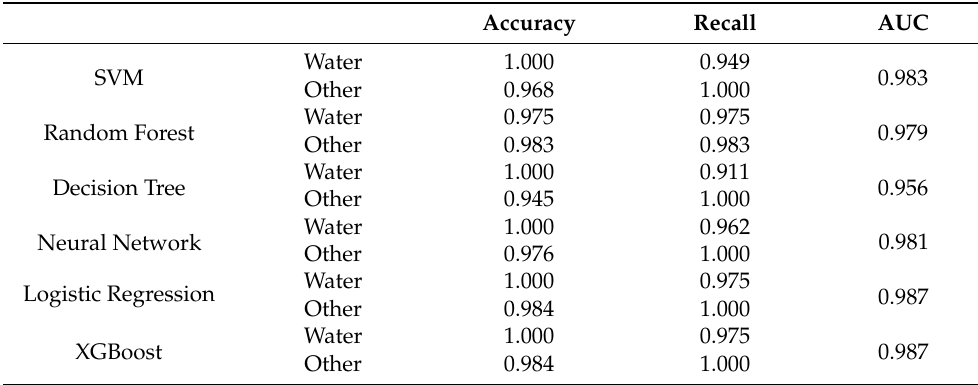
Table 3. Analysis of performance indices of each